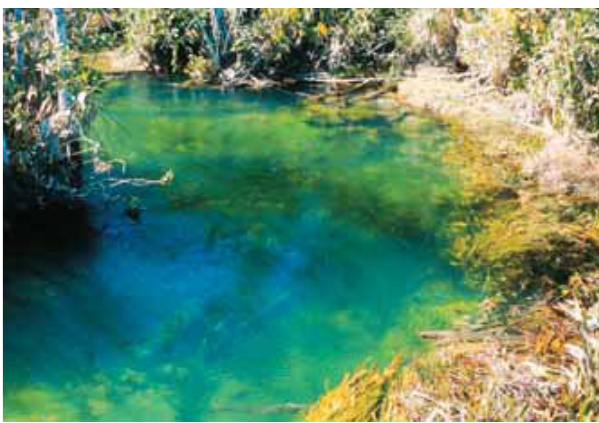
Fig. 8. Type locality of Hyphessobrycon eilyos , ribeirão do Sapo, Mato Grosso, município de Alto Araguaia, Brazil.